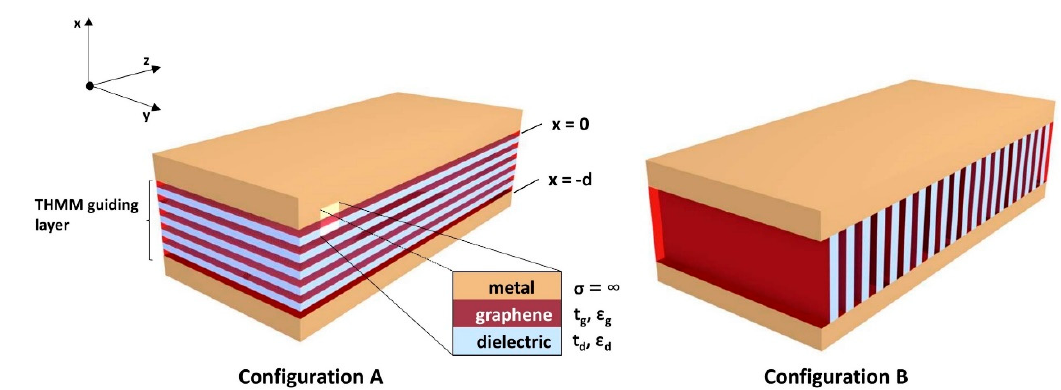
Figure 1. Schematic representation of two waveguide configurations under investigation, configuration A ( left ) and configuration B ( right ), where t g and t d are widths of graphene and dielectric layers, and σ is the conductivity of a perfectly metallic layer.